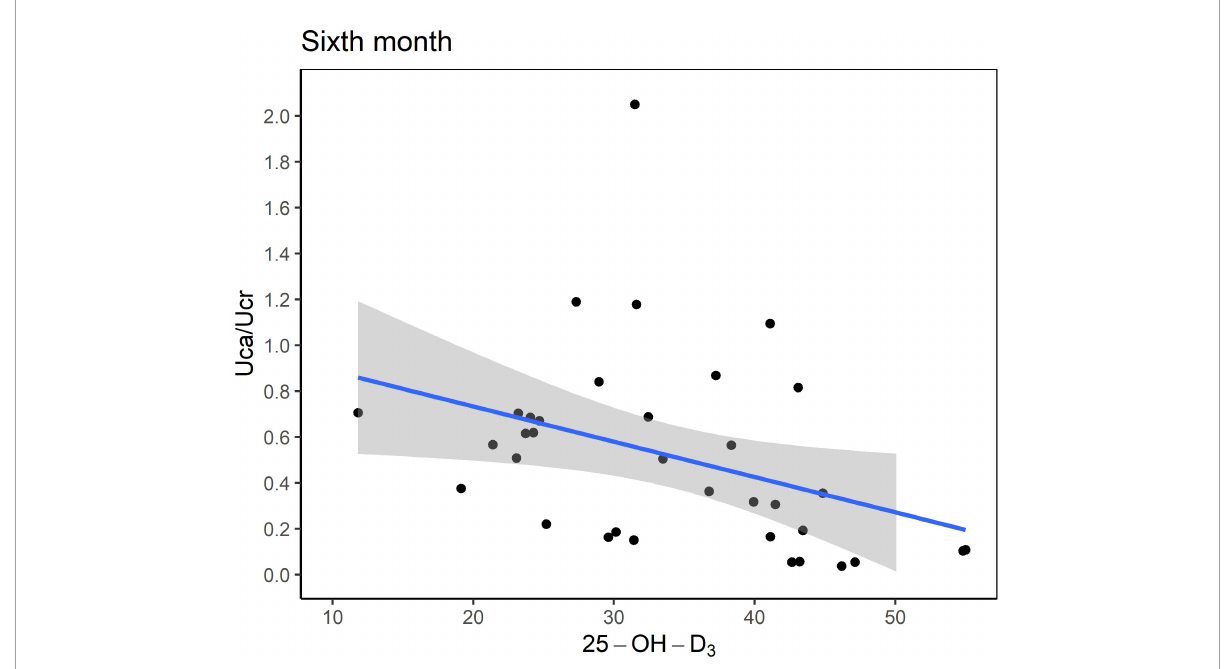
FIGURE1 Scatter plot between the urinary excretion of calcium (Uca) to urinary excretion of creatinine (Ucr) ratio and serum vitamin D level (ng/mL). Uca, urinary excretion of calcium; Ucr, urinary excretion of